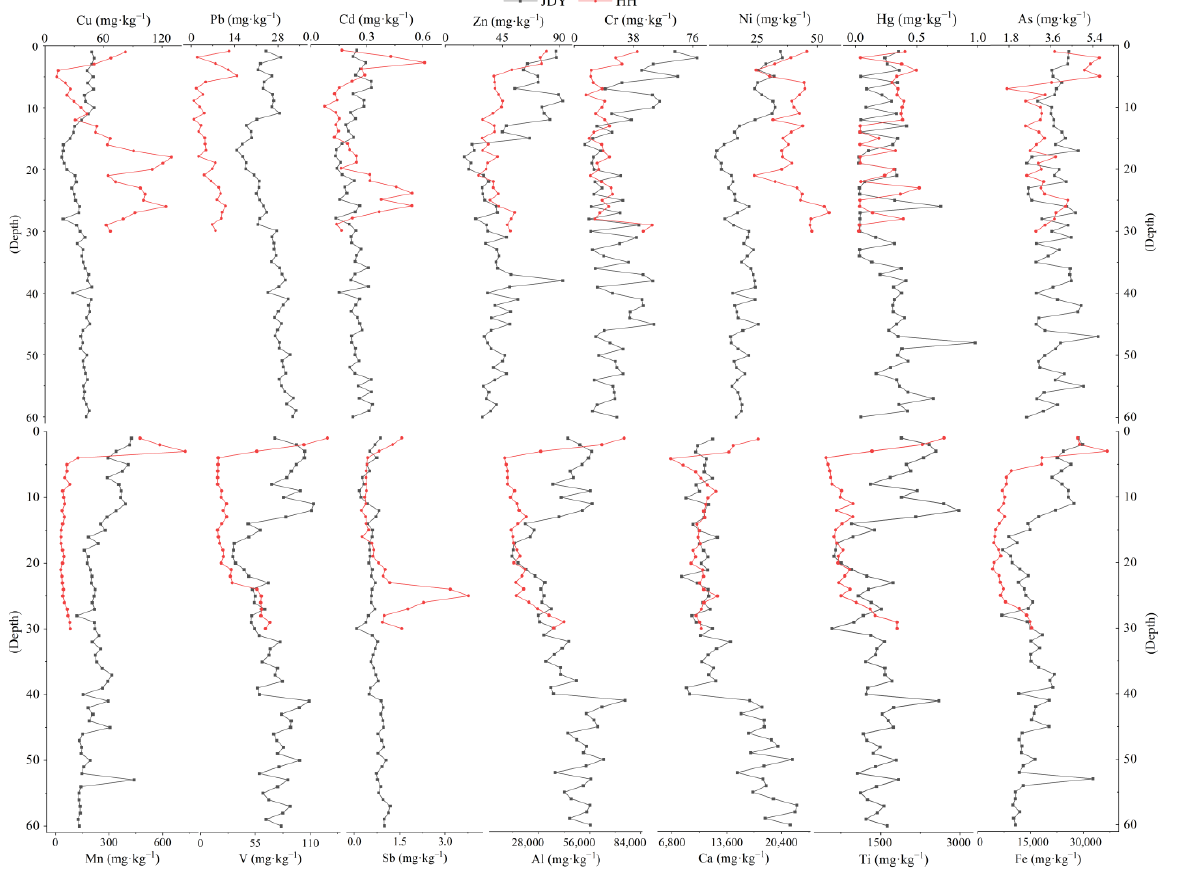
Figure 3. Depth variation characteristics of HMs in JDY and HH peatlands.